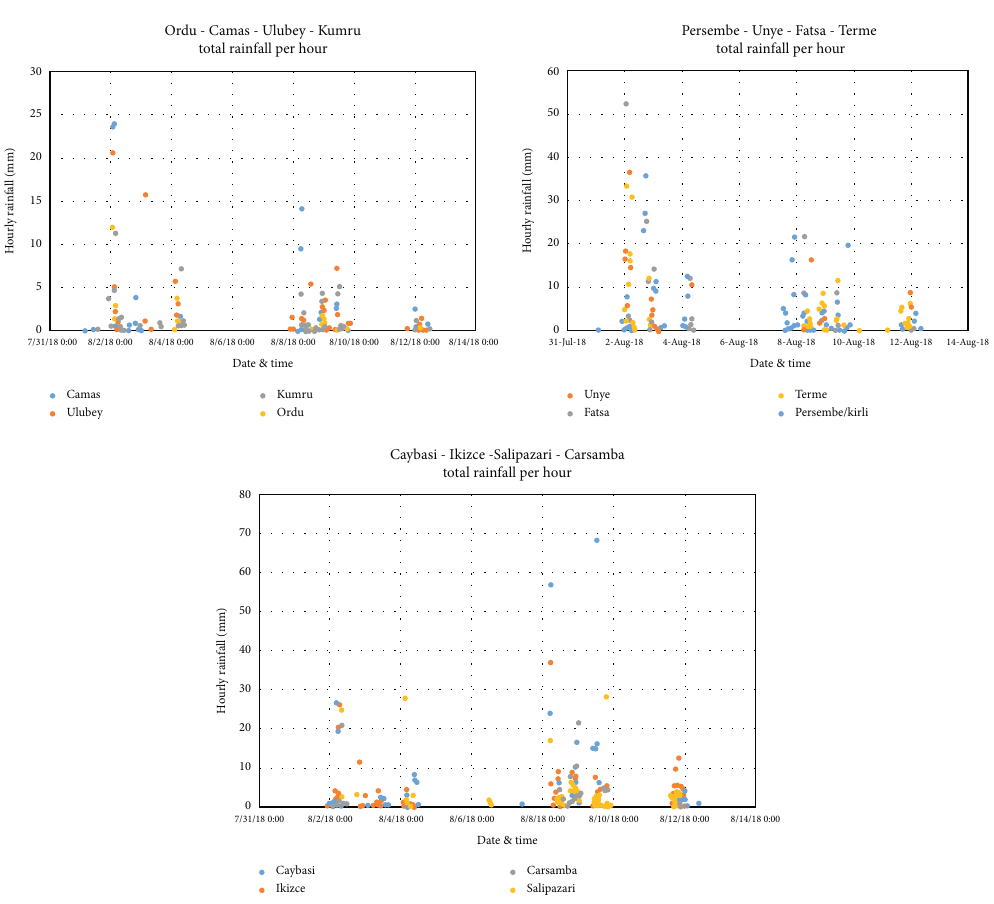
Figure 8: Hourly rainfall in selected stations between 1 and 15 August